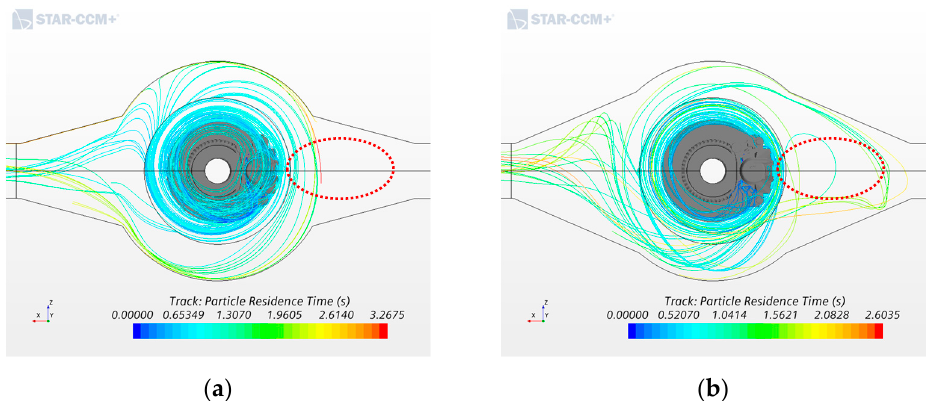
Figure 9. Particle residence time for the inlet and outlet angles of the enclosure: ( a ) α = 15°; ( b ) α = 23°.